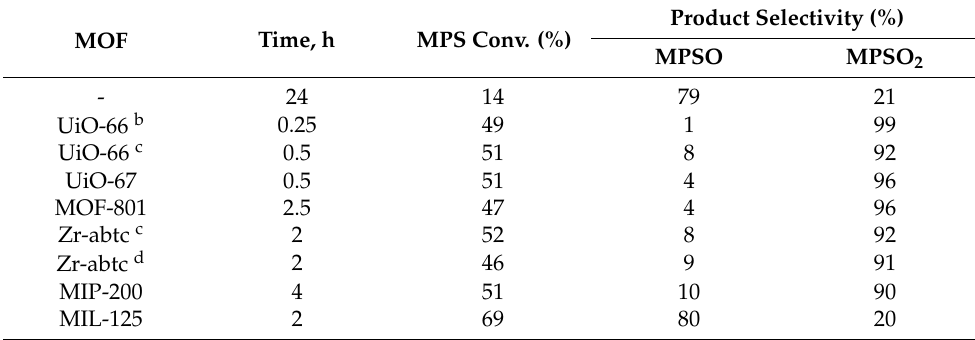
Product Selectivity (%) MPSO